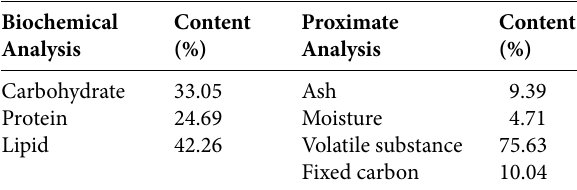
Table 1. Chemical composition and proximate analysis of C. minu- tissima